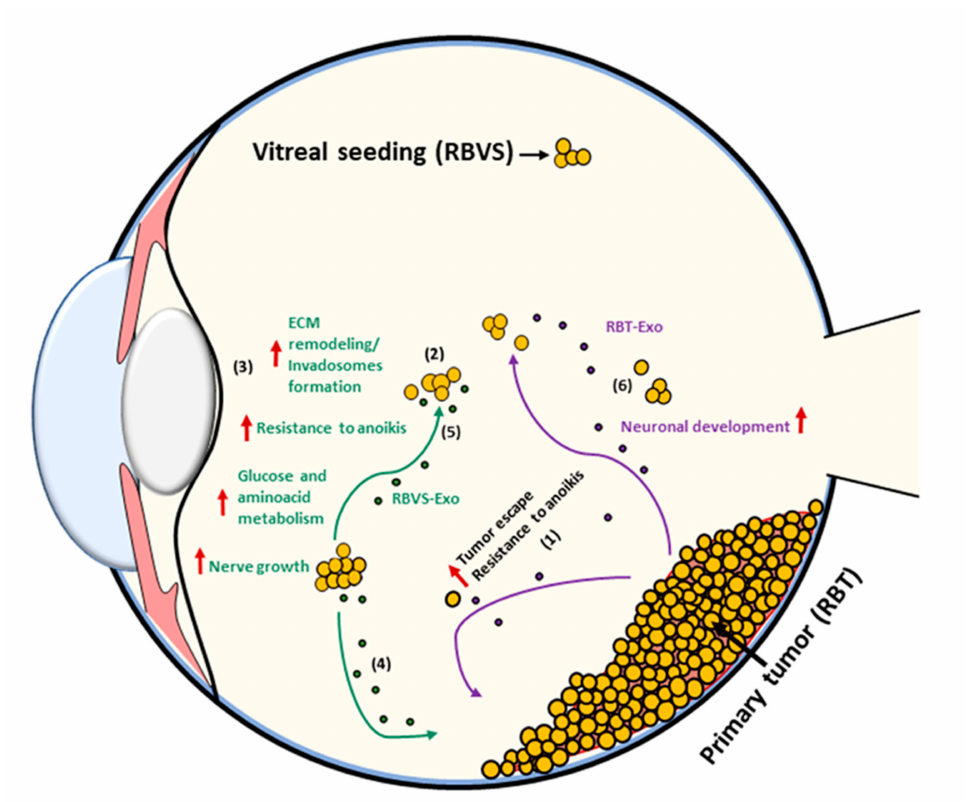
Figure 8. Schematic model of RBVS-exosomes role in vitreous seeding formation. From primary tumor few cells (RBT) that are able to survive in the hypoxic environment of the eye and that acquire resistance to anoikis, escape from the primary mass (1) and establish a metastasis in the vitreous (RBVS) (2) . Exosomes secreted by RBVS cells are enriched in proteins implicated in ECM remodeling / invadosomes formation, resistance to anoikis, changes in metabolism and nerve growth (3) . These cells can be up-taked by: (i) RBT cells inducing an invasive phenotype transferring their protein cargo and inducing anoikis resistance, formation of invadosomes, changes in metabolism in target cells (4) or (ii) by RBVS- cells strengthening their aggressiveness (5) . RBT-exosomes are enriched in proteins involved in neuronal development (6)